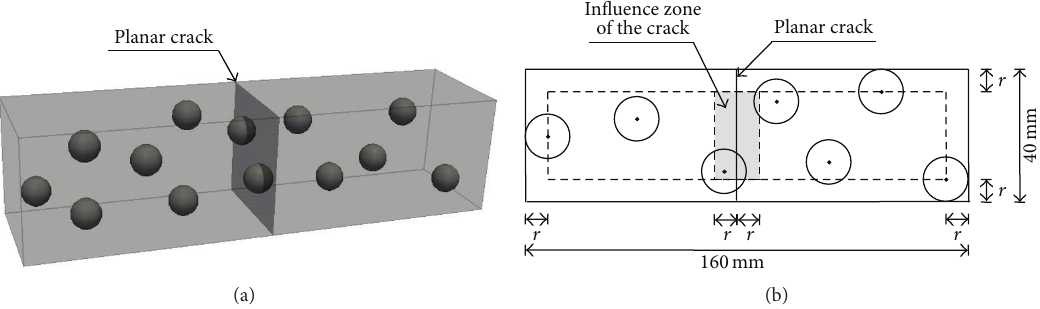
Figure 6: Schematic diagram of a planar crack hitting capsules (a). Planform for the capsule distribution in the sample and the influence zone of the planar crack (b).